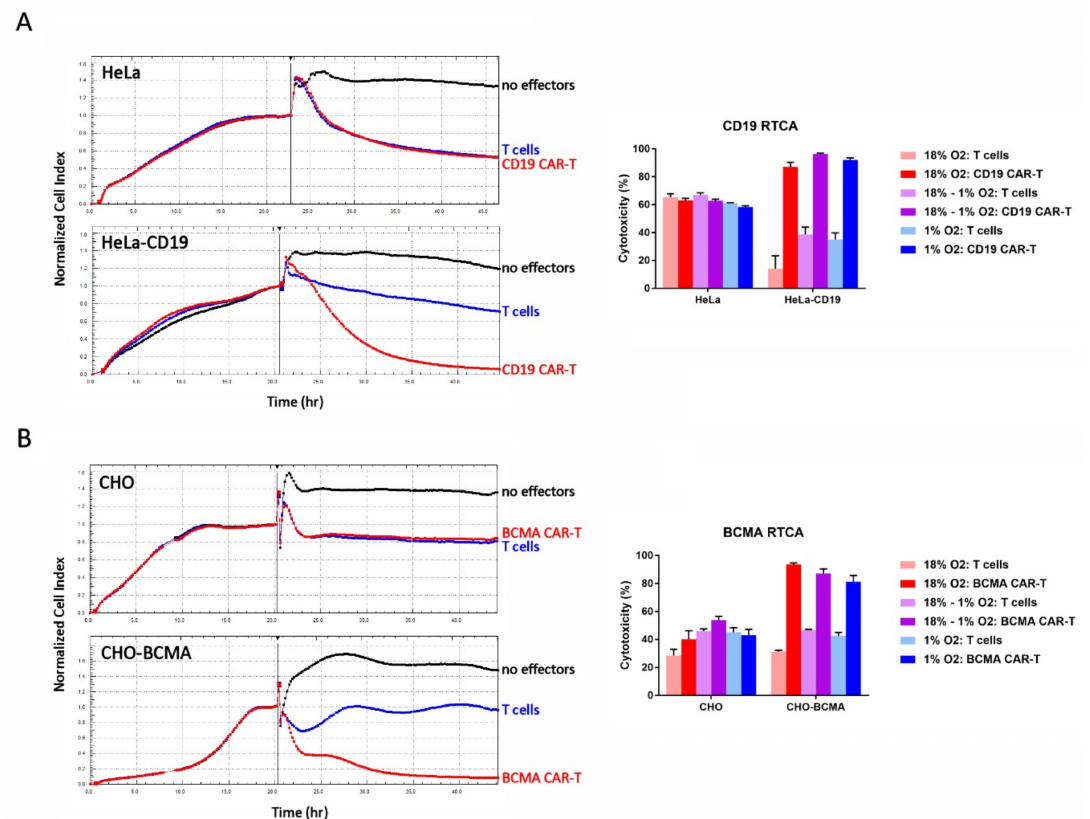
Figure 5. Hypoxia does not a ff ect CAR-T cell cytotoxicity. ( A ) CD19 CAR-T cell RTCA assay. ( B ) BCMA CAR-T cell RTCA assay. Left: HeLa, HeLa-CD19, CHO, and CHO-BCMA cells were monitored overnight as they adhered to the plate and formed a monolayer. The next day, atmospheric CD19 CAR-T cells, BCMA CAR-T cells or control T cells were added to the monolayers at an E:T ratio of 10:1 (vertical bars). The cultures were monitored for approximately 24 more hours. Traces show the average of 3 wells. Right: Cytotoxicity in the RTCA assays was calculated at the end of the assays. Data-points represent the average and standard error of 4 separate